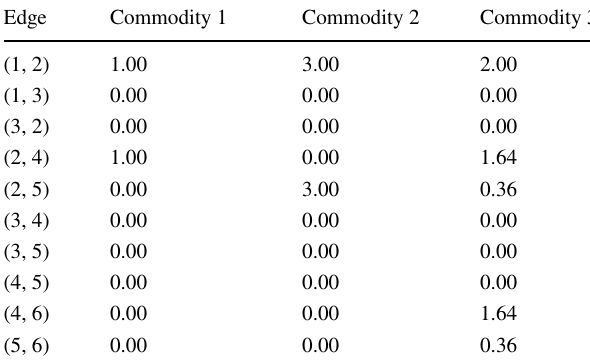
Table 7 Optimal solution for the Example 6.1